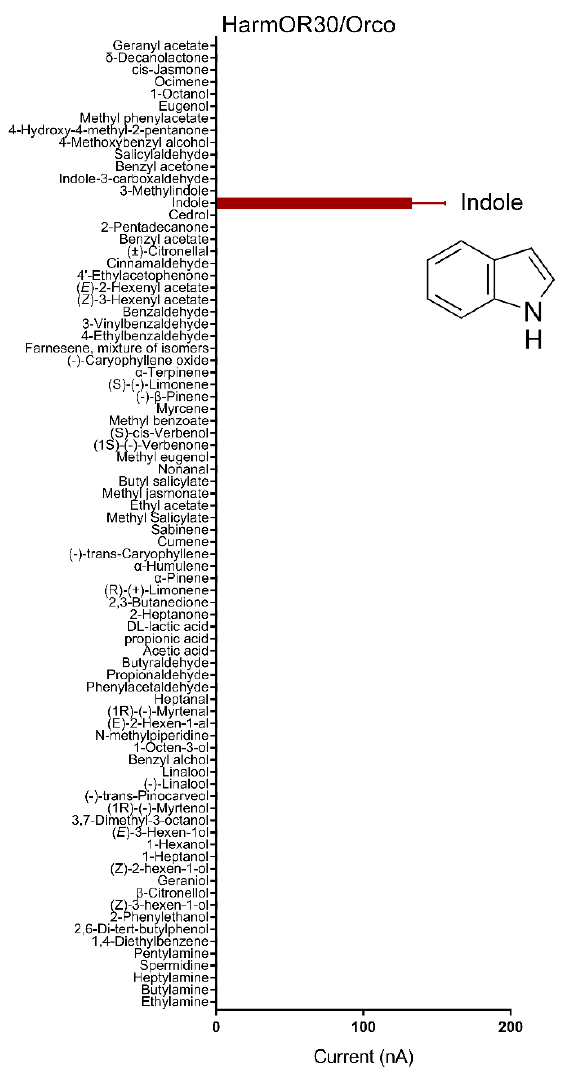
Figure 1. Functional characterization of HarmOR30/Orco in Xenopus oocytes against eighty com- pounds at the dosage of 10 − 4 M. The red column represents the response of HarmOR30 to indole.